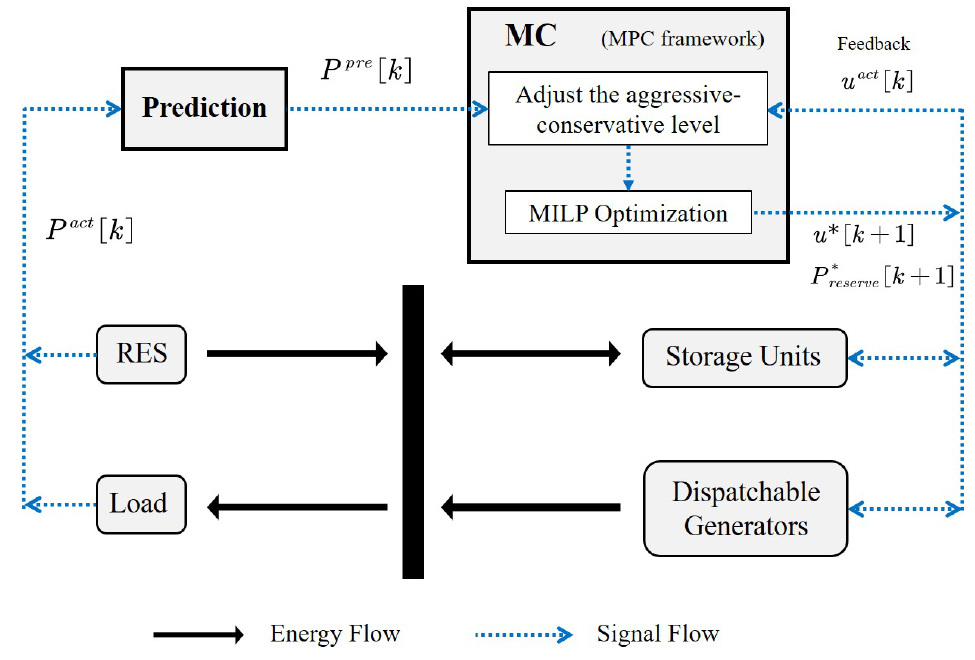
Figure 5. The energy flow and the signal flow in the system using our method.